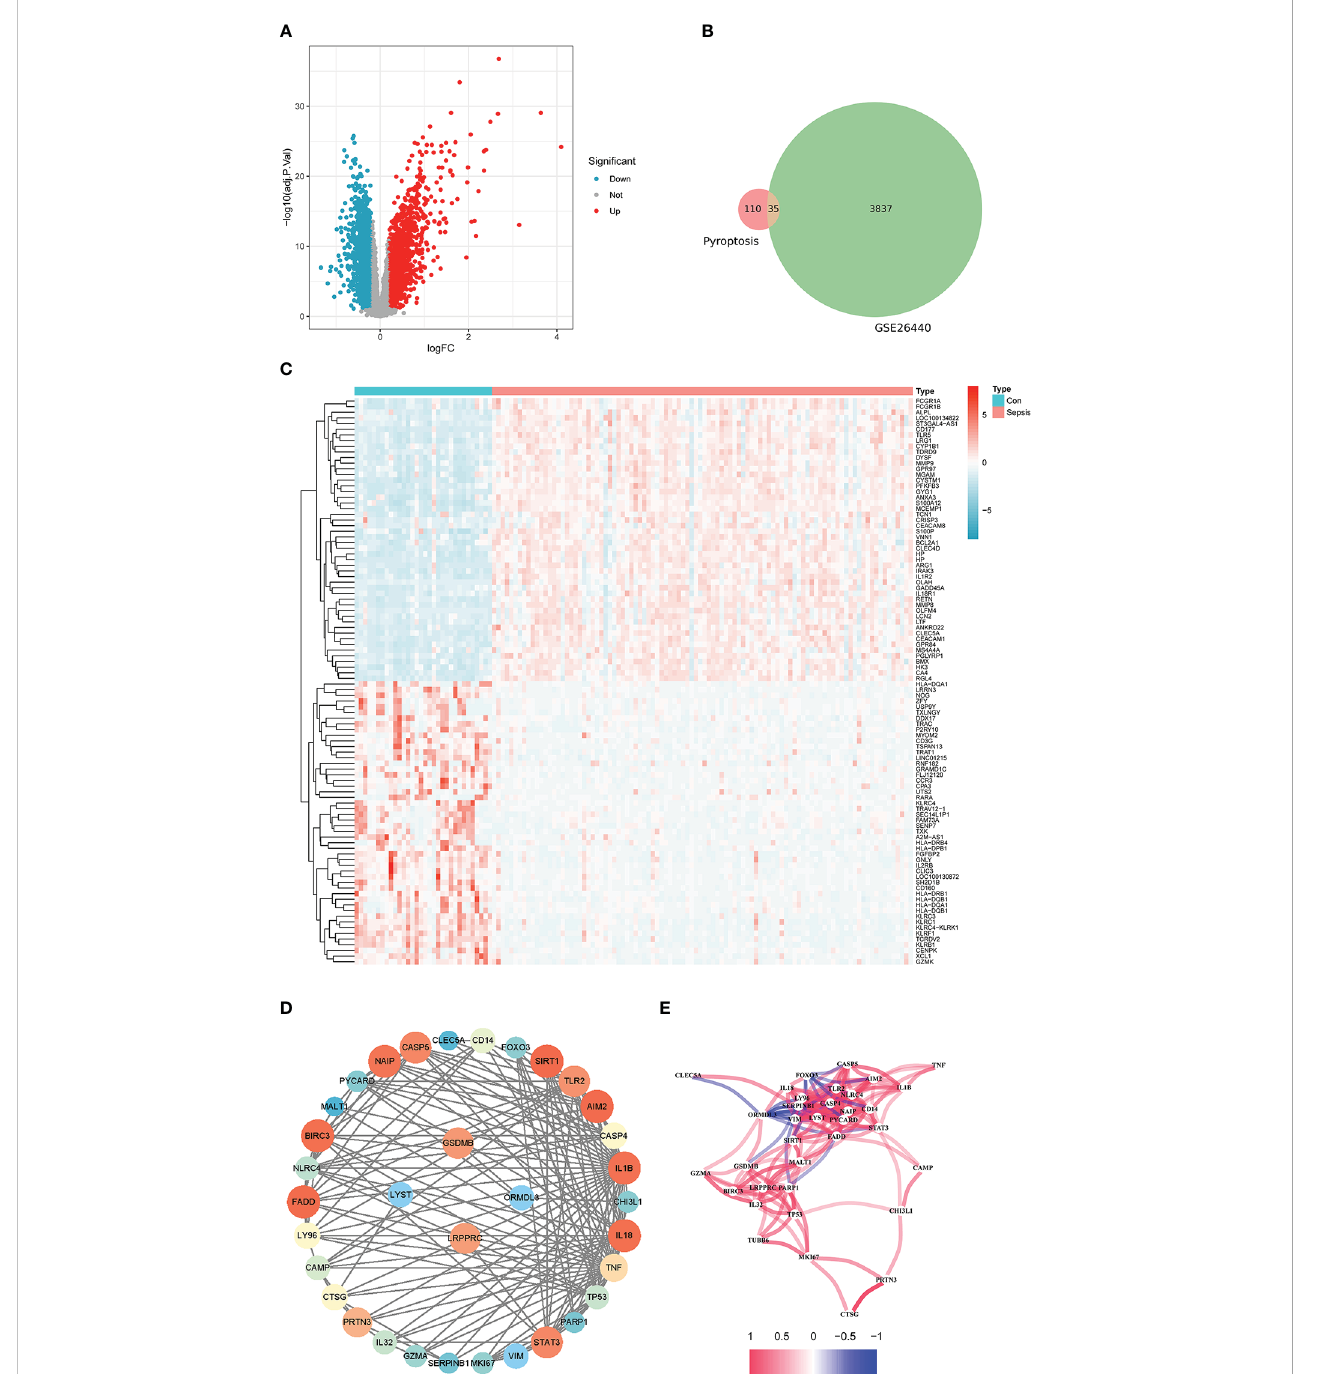
FIGURE 1 Differential analysis of the internal training set. (A) is the volcano plot from the difference analysis. (B) is a Venn diagram of pyroptosis-related genes plotted against the differentially expressed genes of the training set. (C) is the expression heatmap of the top 50 up-regulated and down-regulated genes by absolute logFC. (D) is the PPI network constructed by the intersection genes of DEGs and pyroptosis-related genes. (E) is a correlation network plot among intersecting